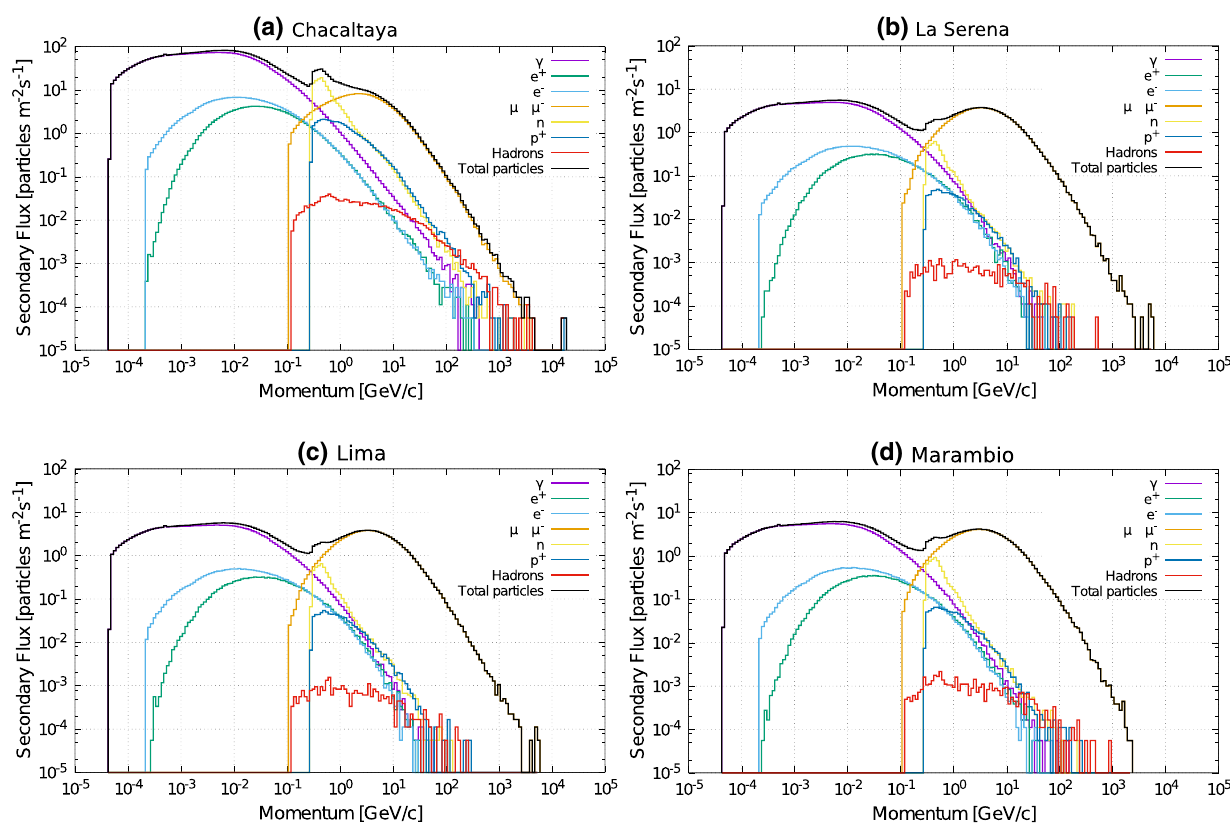
Fig. 3 Spectraofthesecondaryparticlesdiscriminatedbyparticletype at four LAGO sites: a Chacaltaya (CHA), Bolivia (5240m a.s.l.); b La Serena (LSC), Chile (28m a.s.l.); c Lima (LIM), Perú (150m a.s.l.) and d Marambio Base (SAWB), Antarctica (200m a.s.l.). The comparison